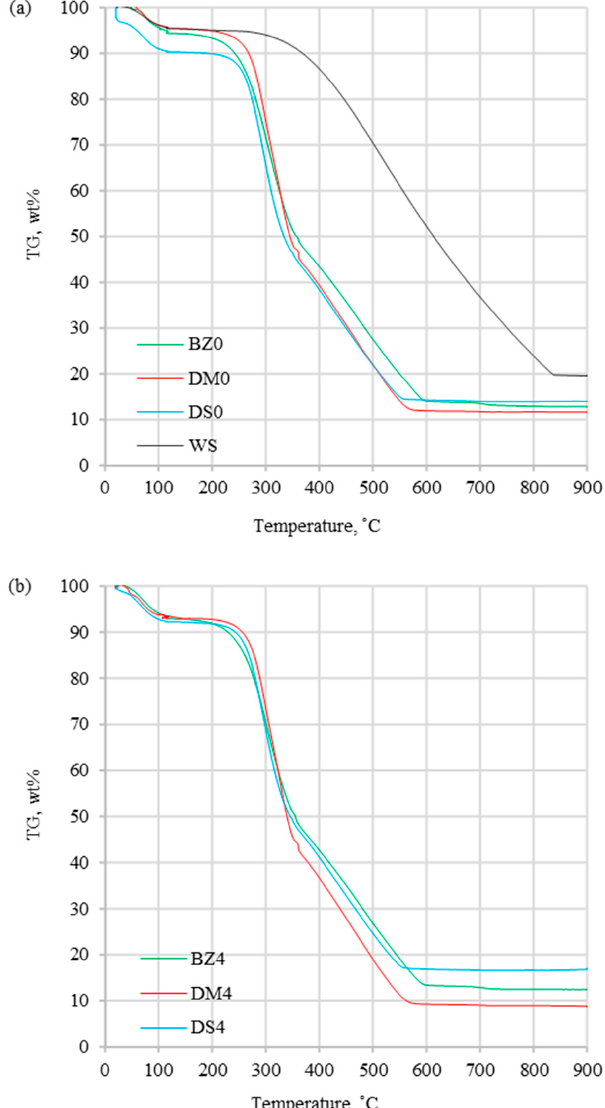
Figure 4. TG curves for ( a ) fuels without halloysite and ( b ) fuels with halloysite at β = 20 °C/min.